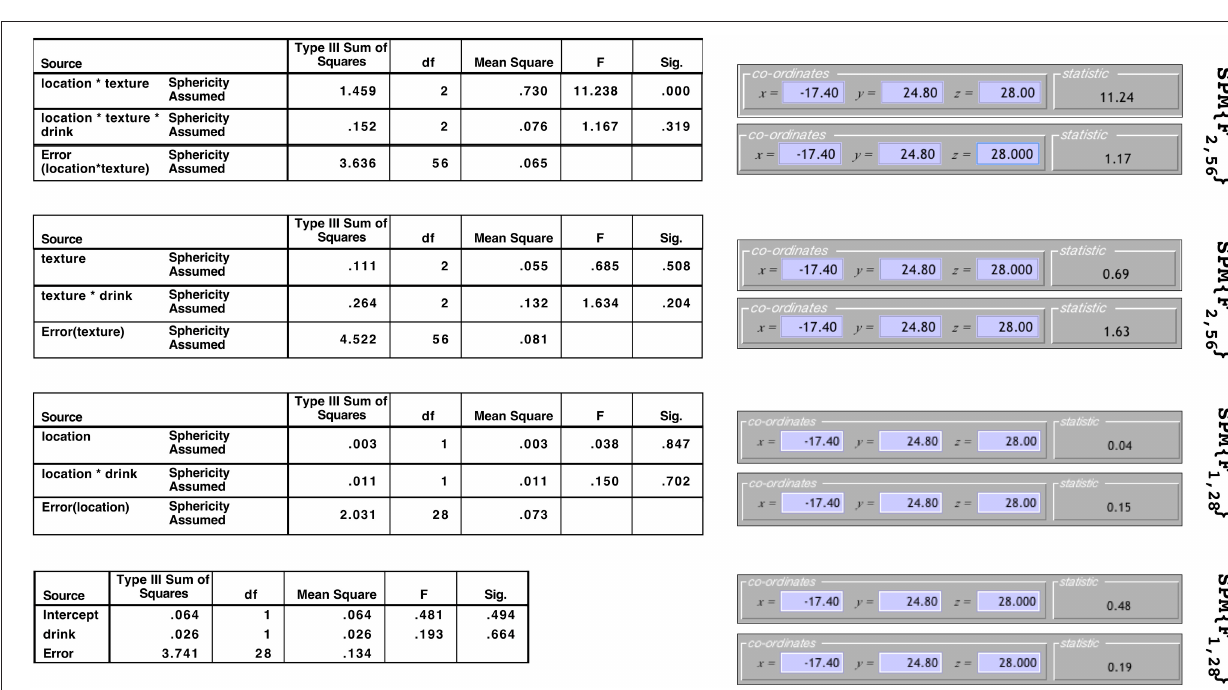
FIGURE 2 | Comparison of the results produced by SPM and SPSS 23 for data from a single voxel. Equivalence of the F -statistics and the degrees of freedom confirms that the correct error terms have been selected and that correct Type III weights have been